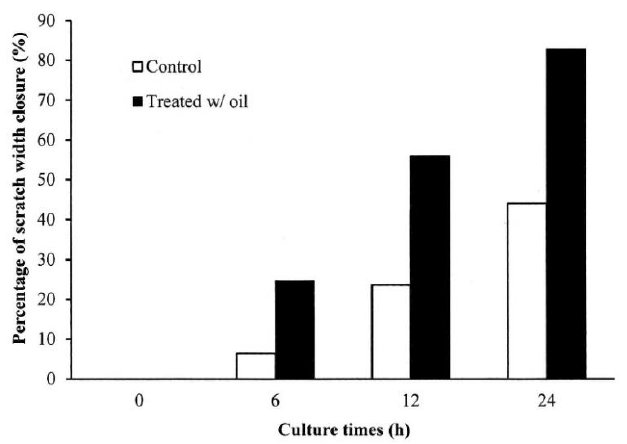
Figure 6. The percentage of scratch-width closure measured by quantifying the images of the scratch assay at 0, 6, 12, and 24 h after incubation. Data are from four independent experiments. The mean value of each group was normalized with LPS-only sample.